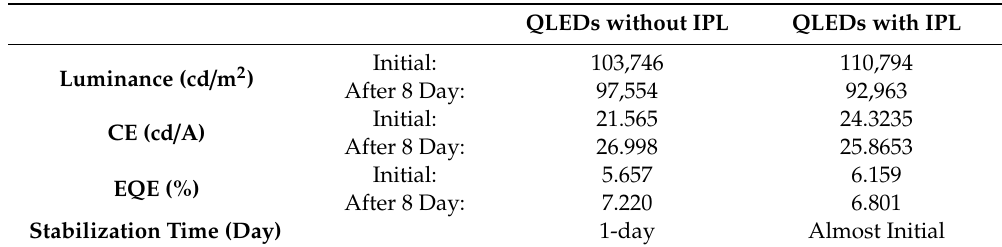
Table 1. The IVL characteristics and stabilization time of device time-dependency of QLEDs by IPL